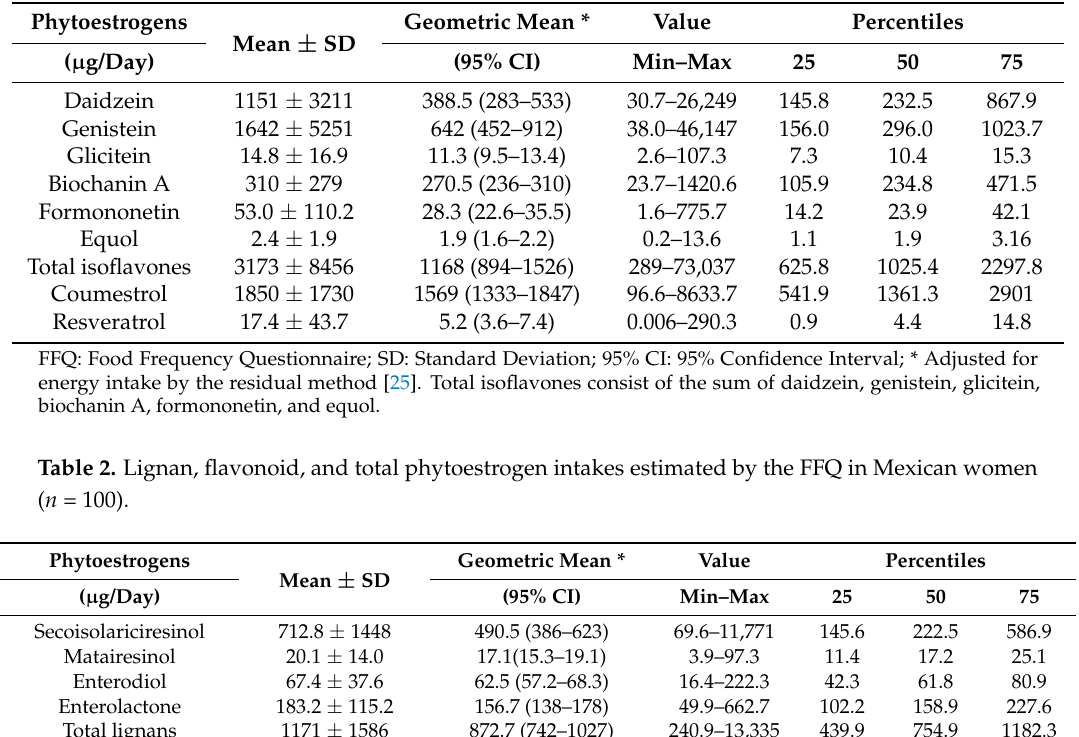
Table 1. Isoflavone, coumestrol, and resveratrol intakes estimated by the FFQ in Mexican women ( n = 100).